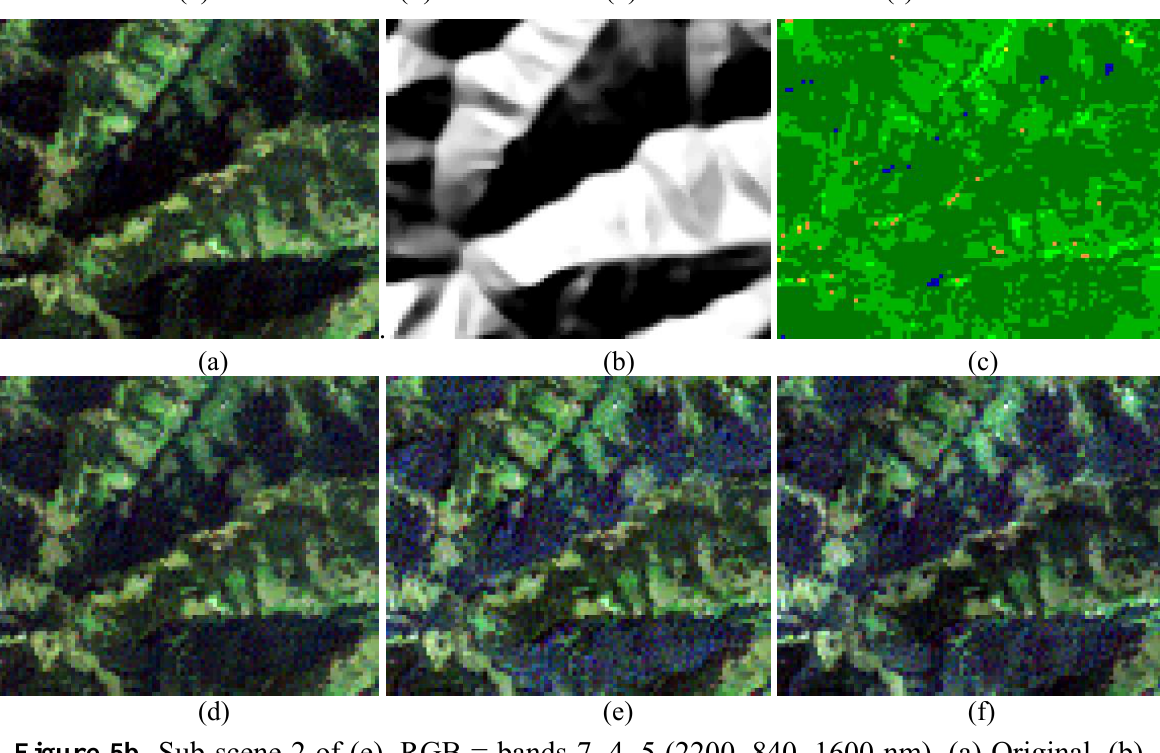
Figure 5a. Sub-scene 1 of (e), RGB = bands 3, 2, 1 at 660, 560, 480 nm. (a) Original. (b) Illumination. (c) Classification. (d) C correction. (e) Gamma correction. (f) MM correction.